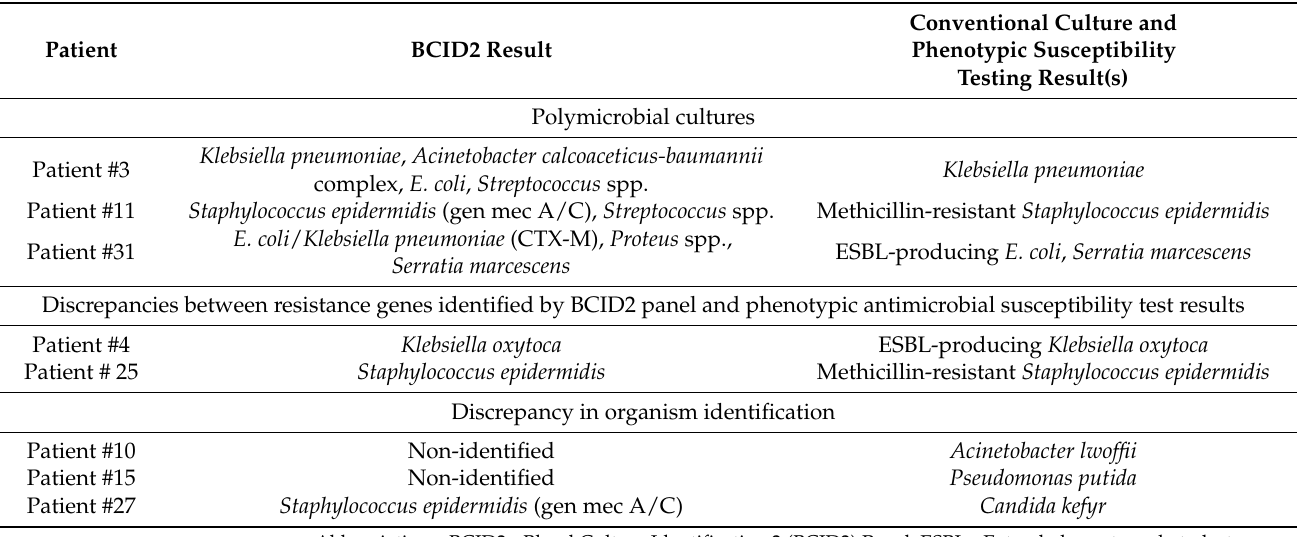
Table 3. Discrepancies between BCID2 and conventional culture and phenotypic antimicrobial susceptibility test